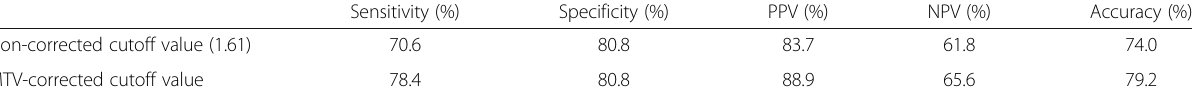
Table 3 Comparison of diagnostic accuracy for recurrence by tumor volume-corrected cutoff values Sensitivity (%) PPV (%) NPV